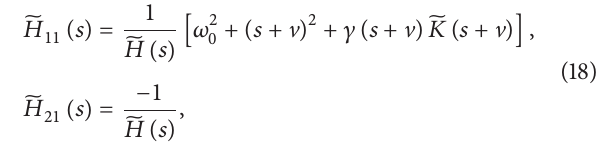
Figure 1: The relationships of the input periodic signals and the output signals by the theory of “signals and